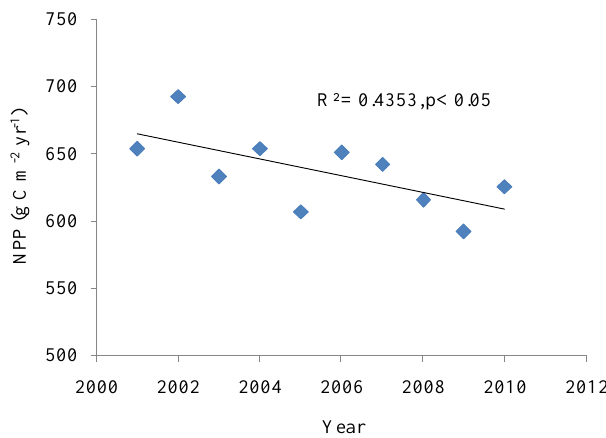
Figure 6. Temporal changes of the total net primary production of Chinese fir in the study region from 2000–2010 exhibit a significant decreasing trend.